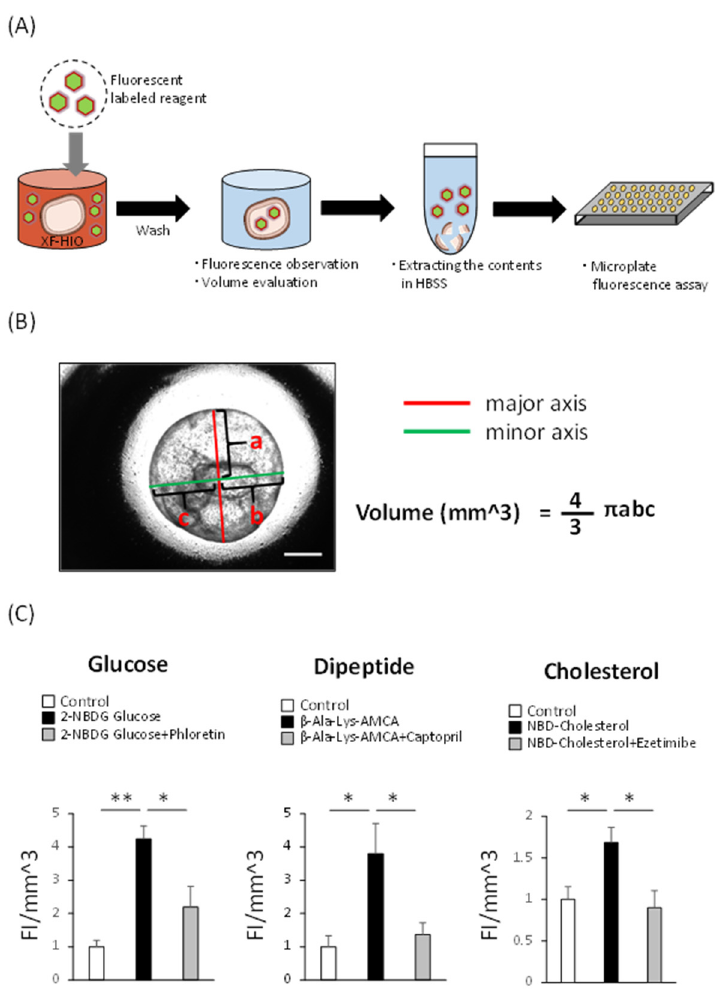
Figure 3. Absorption of glucose, dipeptide, and cholesterol into XF-HIOs in a transporter-dependent manner. ( A ) Diagram of the analysis of absorption using a fluorescent-labeled reagent. ( B ) The major and minor axes of a three-dimensional xenogeneic-free human intestinal organoid (XF-HIO) were automatically measured by the image analysis [19], and the volume was used for the correction of fluorescence intensity. Scale bar: 500 µ m. ( C ) The levels of internal fluorescence intensity of labeled glucose, dipeptide, and cholesterol; control (open columns), treatment with fluorescent-labeled reagents (black columns) and with inhibitors, phloretin, captopril (1 mM) and ezetimibe (20 µ M) (gray columns). PBS, phosphate-buffered saline; HBSS, Hank’s buffered saline solution. Data are presented as the mean ± S.E. values of four independent experiments. * p < 0.05 and ** p < 0.01.